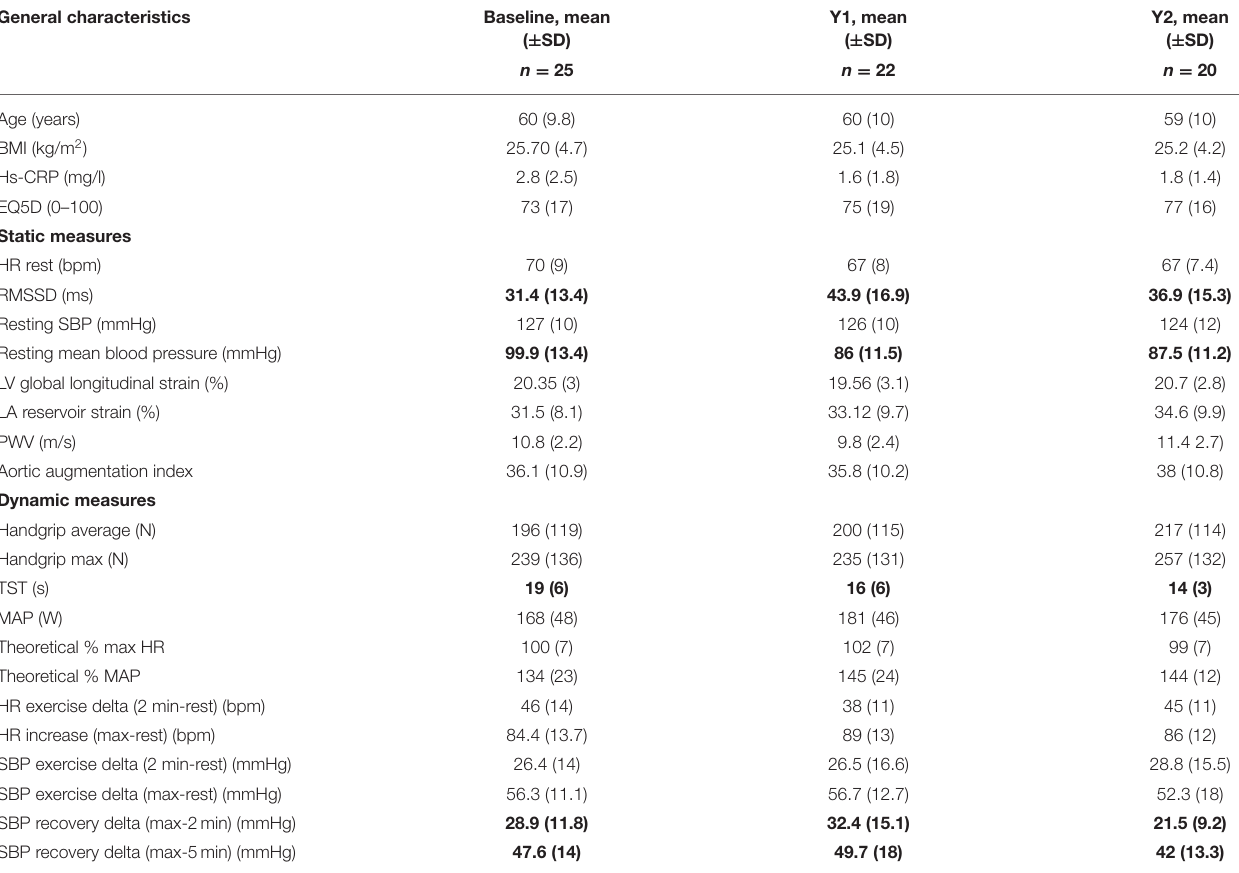
TABLE 1 | General characteristics, static, and dynamic measures of the study cohort at baseline and yearly follow-ups. General